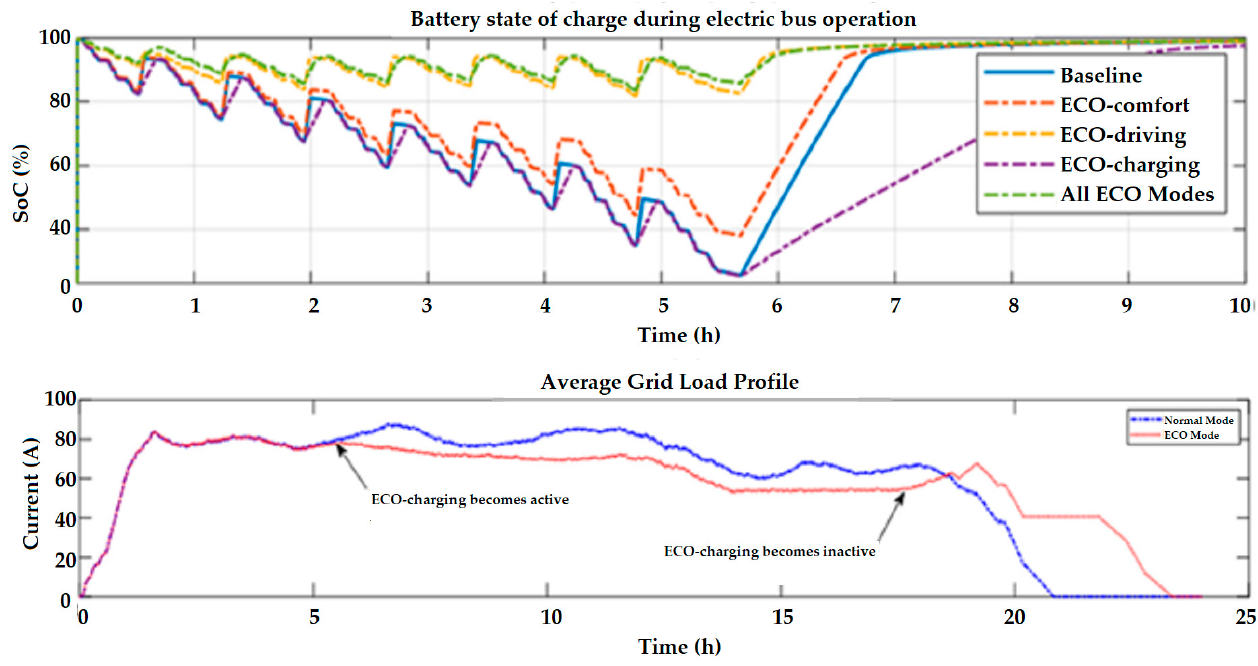
Figure 4. Effects of the ECO ‐ features of the energy requirements ( top row ) and impact on the elec ‐ tricity grid ( bottom row ).